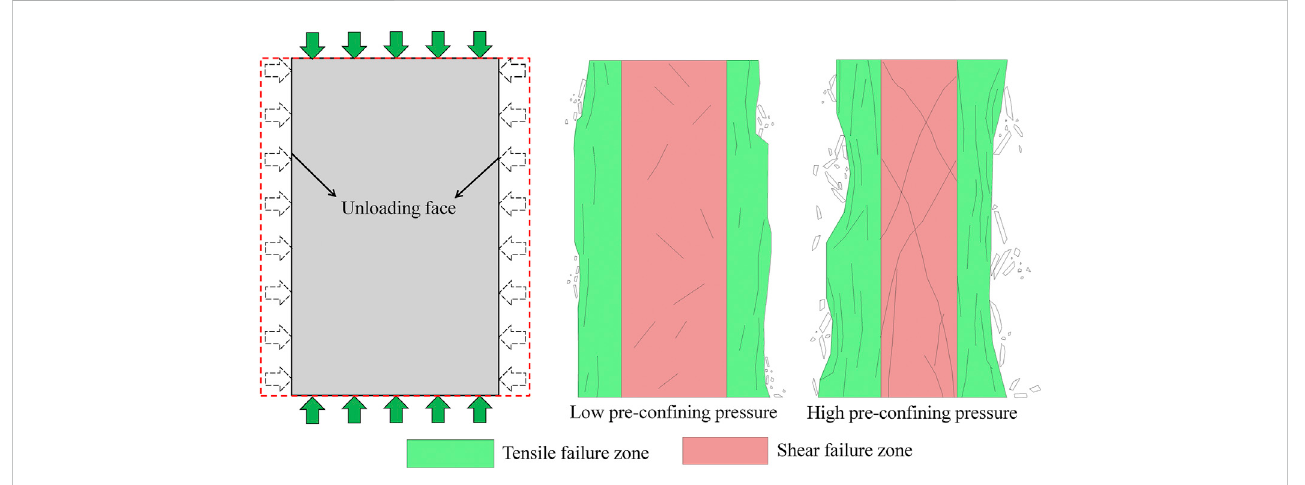
FIGURE 13 Two failure modes of coalburst under different pre-con fi ning pressures.